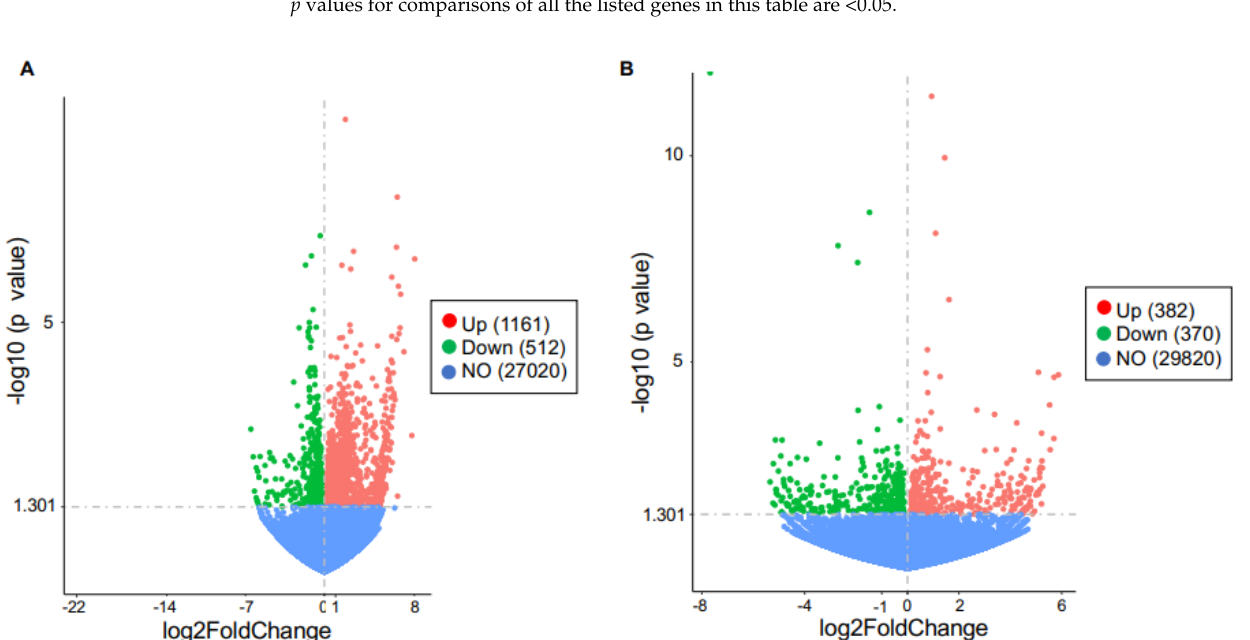
Figure 5. Bulk RNA-sequencing data showing reduced TLR9 gene expression in lung macrophages isolated from TLR9 CKO mice treated with BSA as compared to the cells from TLR9-sufficient mice treated with BSA. FPKM stands for fragments per kilobase of transcript per million mapped reads, indicating a relative expression of a gene proportional to the number of cDNA fragments of origin. n = 4 to 7 mice per group.